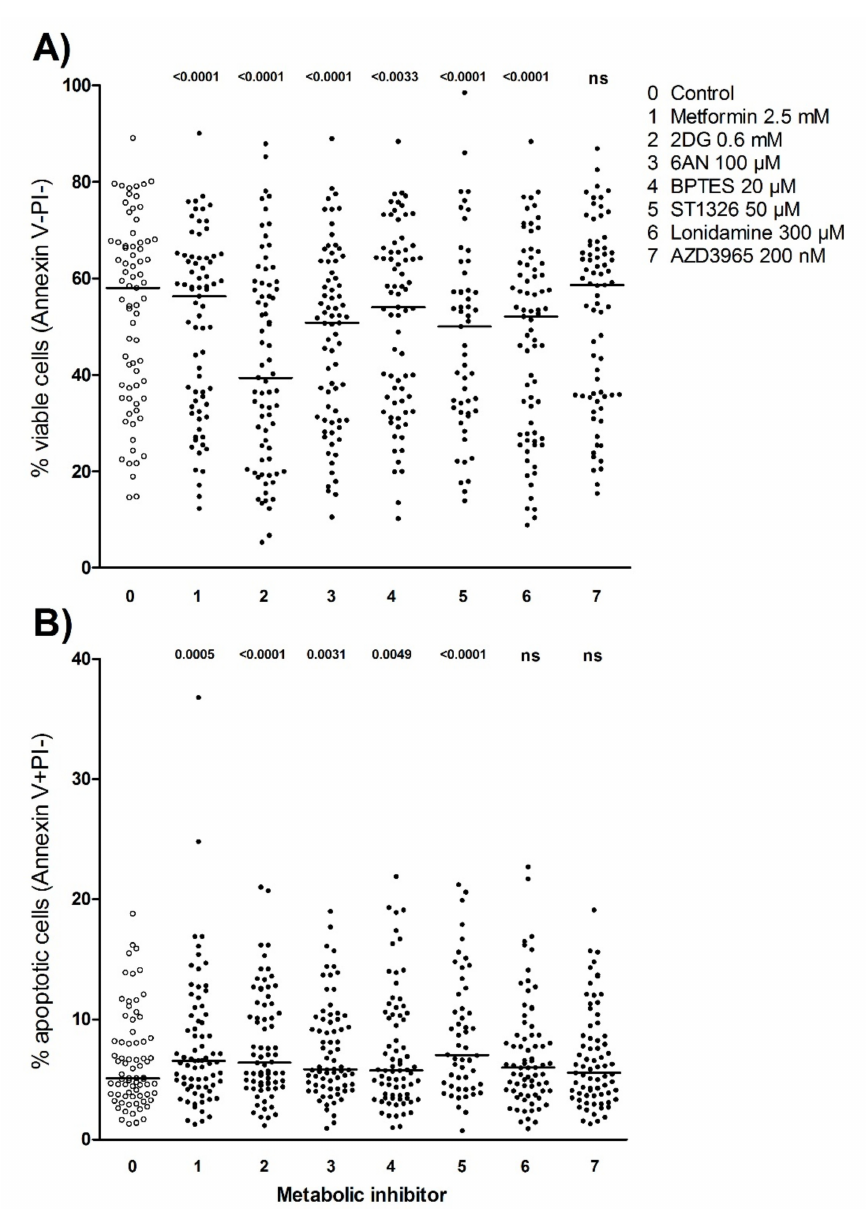
Figure 4. E ff ects of metabolic inhibitors on AML cell viability and apoptosis. AML cells derived from 78 consecutive patients were cultured for 2 days in suspension cultures in medium supplemented with growth factors with or without metabolic inhibitors, before the percentage of viable and apoptotic cells were determined by flow cytometry using the AnnexinV / PI apoptosis assay. Seventy-two patients had more than 5% viable cells in untreated control cultures and were used in the statistical analyses. The percentage of ( A ) viable and ( B ) early apoptotic cells for all 72 patients is presented. Each dot represents results for one patient sample, solid lines indicate median values. Significant e ff ects ( p -values) of inhibitor treatment compared to untreated controls are shown (Wilcoxon signed rank test; ns, not